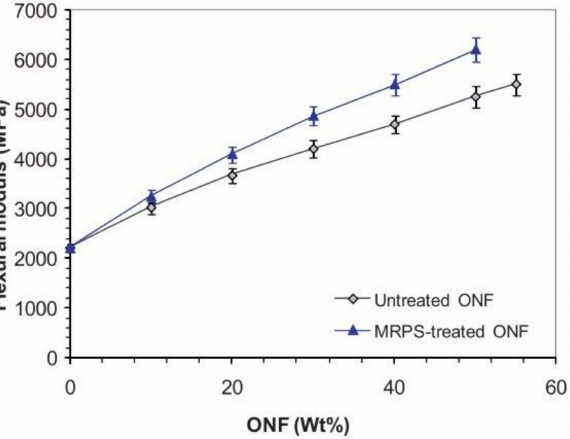
Figure 9. Evolution of the flexural modulus versus ONF (olive nuts flour) content [61]. Compared to neat resin, composites with 10, 30, 40, and 55 wt.% of ONF exhibited flexural modulus around 1.36, 1.9, 2.07, and 2.51 times higher, respectively. However,